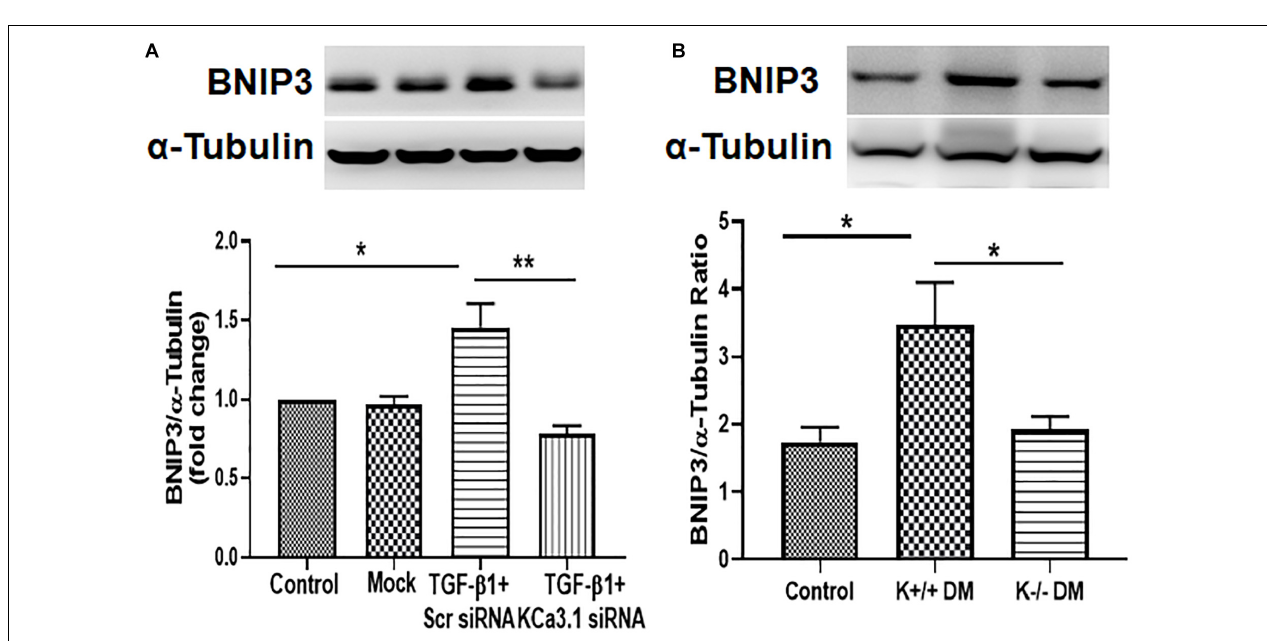
FIGURE 6 | KCa3.1 deficiency suppressed diabetes-induced upregulation of BNIP3 expression in HK2 cells and diabetic mice. (A) Western blot analysis showed that KCa3.1 silencing inhibited TGF- β 1-induced BNIP3 expression in HK2 cells. N = 3. (B) Western blot analysis revealed an increased expression of BNIP3 in diabetic KCa3.1+/+ mice, which were significantly attenuated in KCa3.1 deficiency mice (K − / − DM). Results are presented as mean ± SEM. * P < 0.05, ** P < 0.01, N =